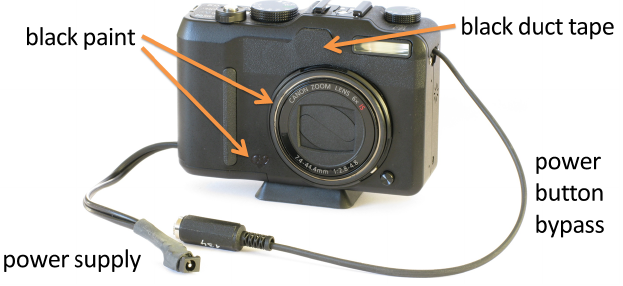
Figure 10. Modified Canon PowerShot G9